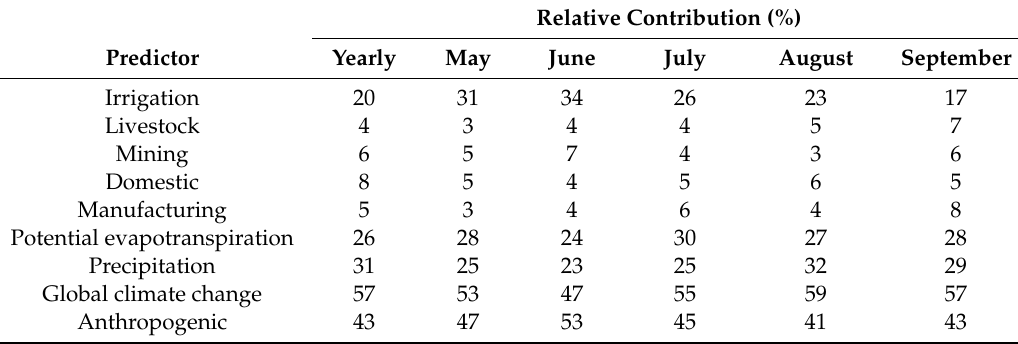
Table 2. Summary of the relative contributions (%) of predictor variables for a boosted regression tree model developed with cross validation on water surface area data using tree complexity of 5 and learning rate of 0 ·